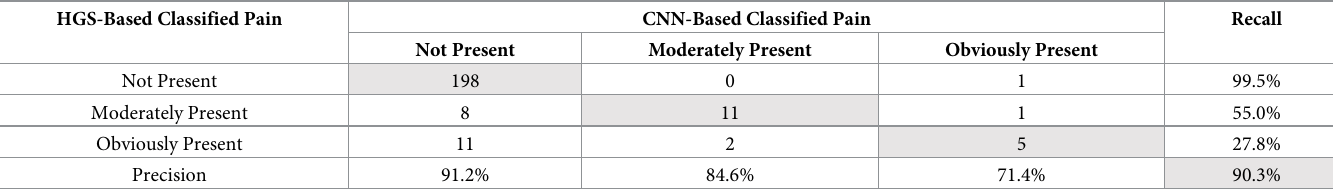
Table 4. Confusion matrix between the data classified by the CNN-based model and HGS for the ears images. HGS-Based Classified Pain